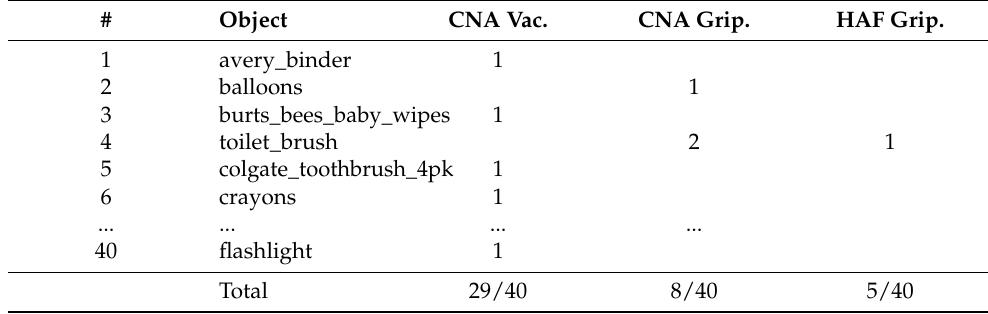
Table 3. Optimization table for ARC’17